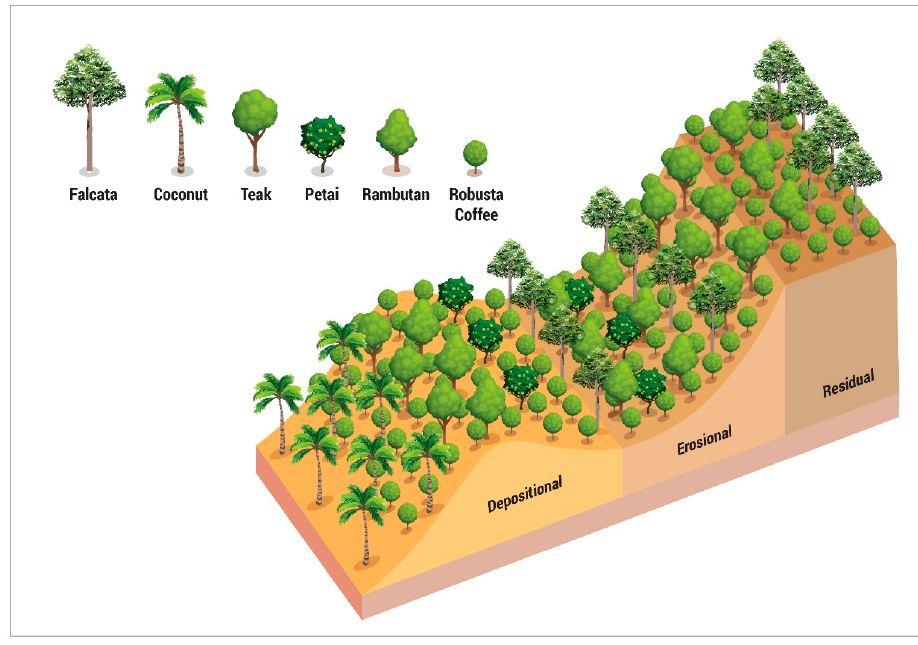
Figure 5. Actual plant layout in the existing agroforestry.